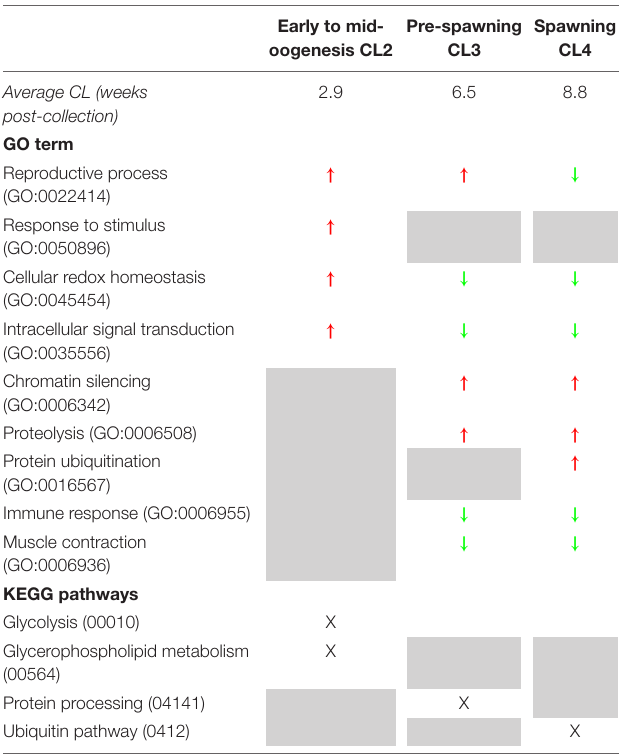
TABLE 1 | Transcriptional differences between Neocalanus flemingeri females in diapause and in post-diapause. Relative gene expression of diapausing females (CL1) were compared with females in three other major clusters (columns) identified using hierarchical clustering ( Figure 2 ).